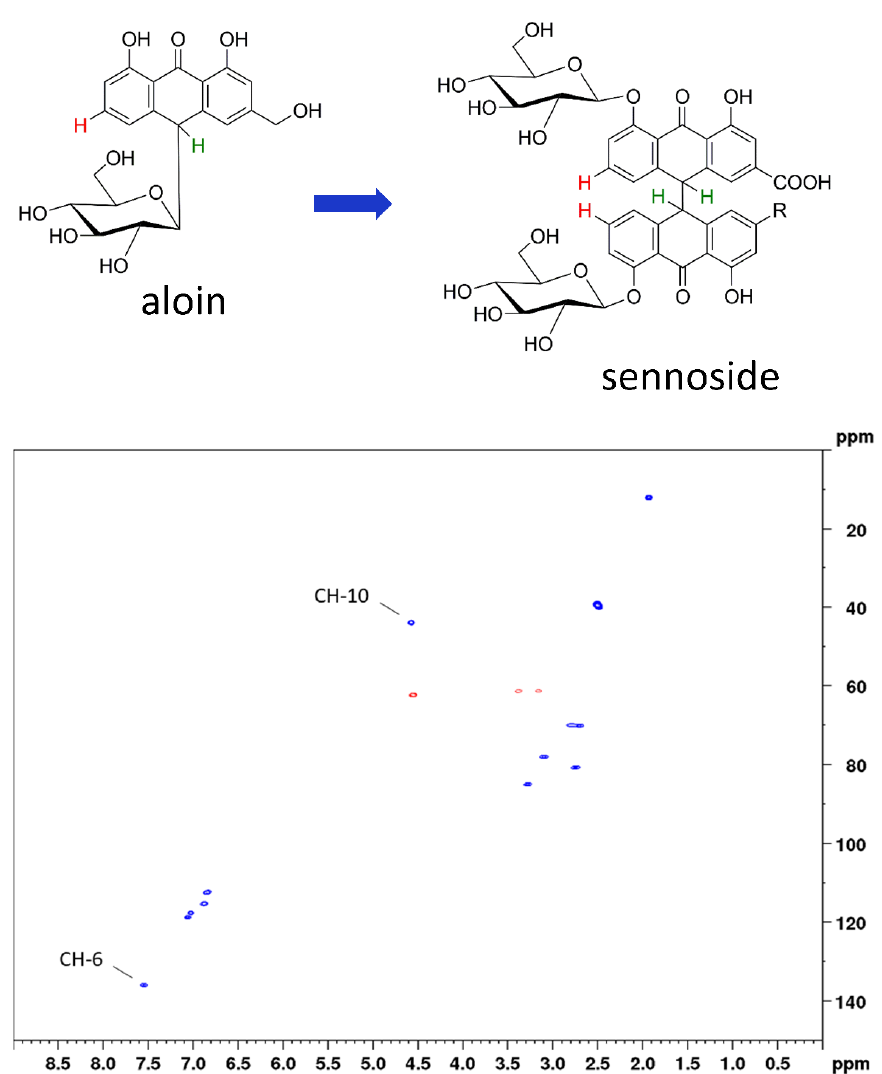
Figure 2. Top : chemical structures of surrogate standard aloin and the assayed sennosides with the relevant protons marked in green (H-10 for total sennoside content) and red (H-6 for the content of sennosides A, B, and A 1 ). Bottom : HSQC diagram of aloin indicating the respective cross peaks used for calibration.